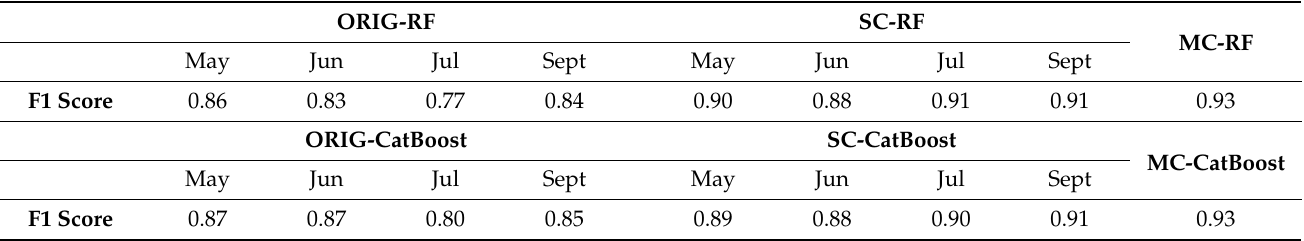
Table 6. F1 scores for rice under different classification schemes.